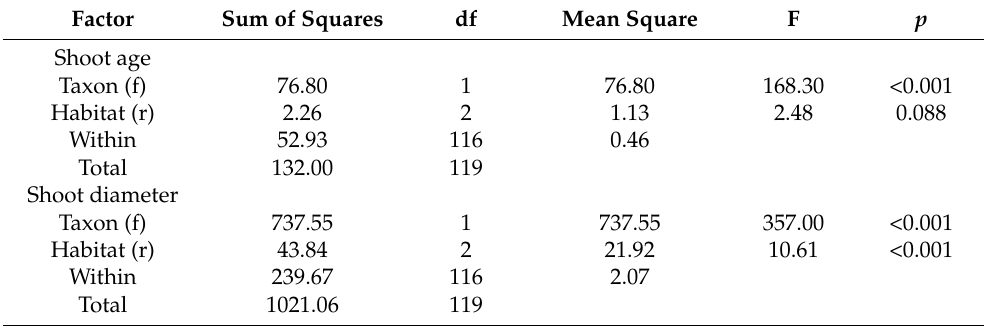
Table 3. Results of a two-way nested ANOVA analysis showing the effect of the taxon (fixed effect: f) and habitat (random effect: r) on the age and diameter of the shoots that had started fruiting.